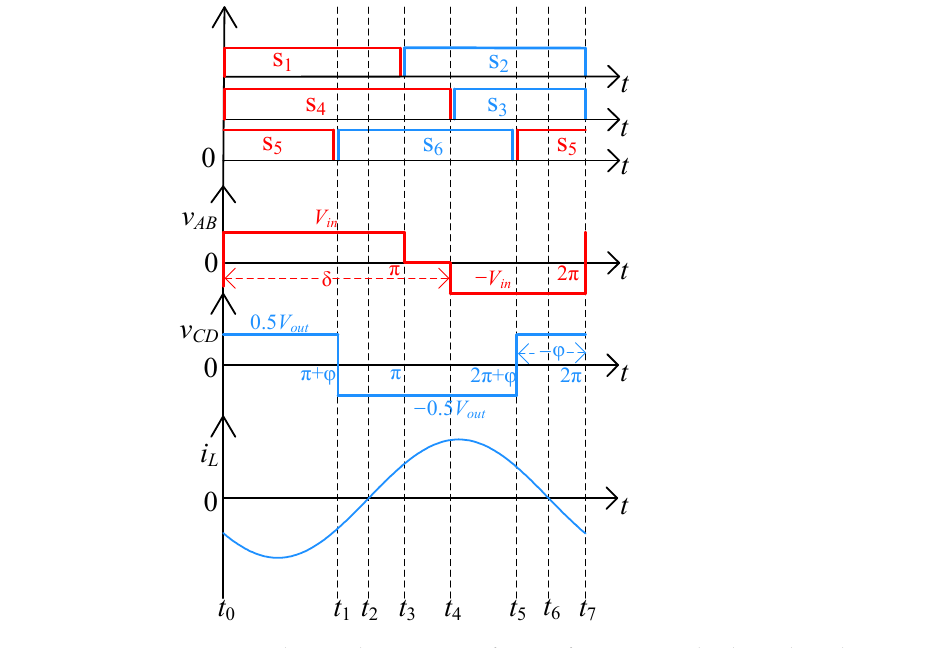
Figure 4. The steady-state waveforms of H-DBRC in backward mode.